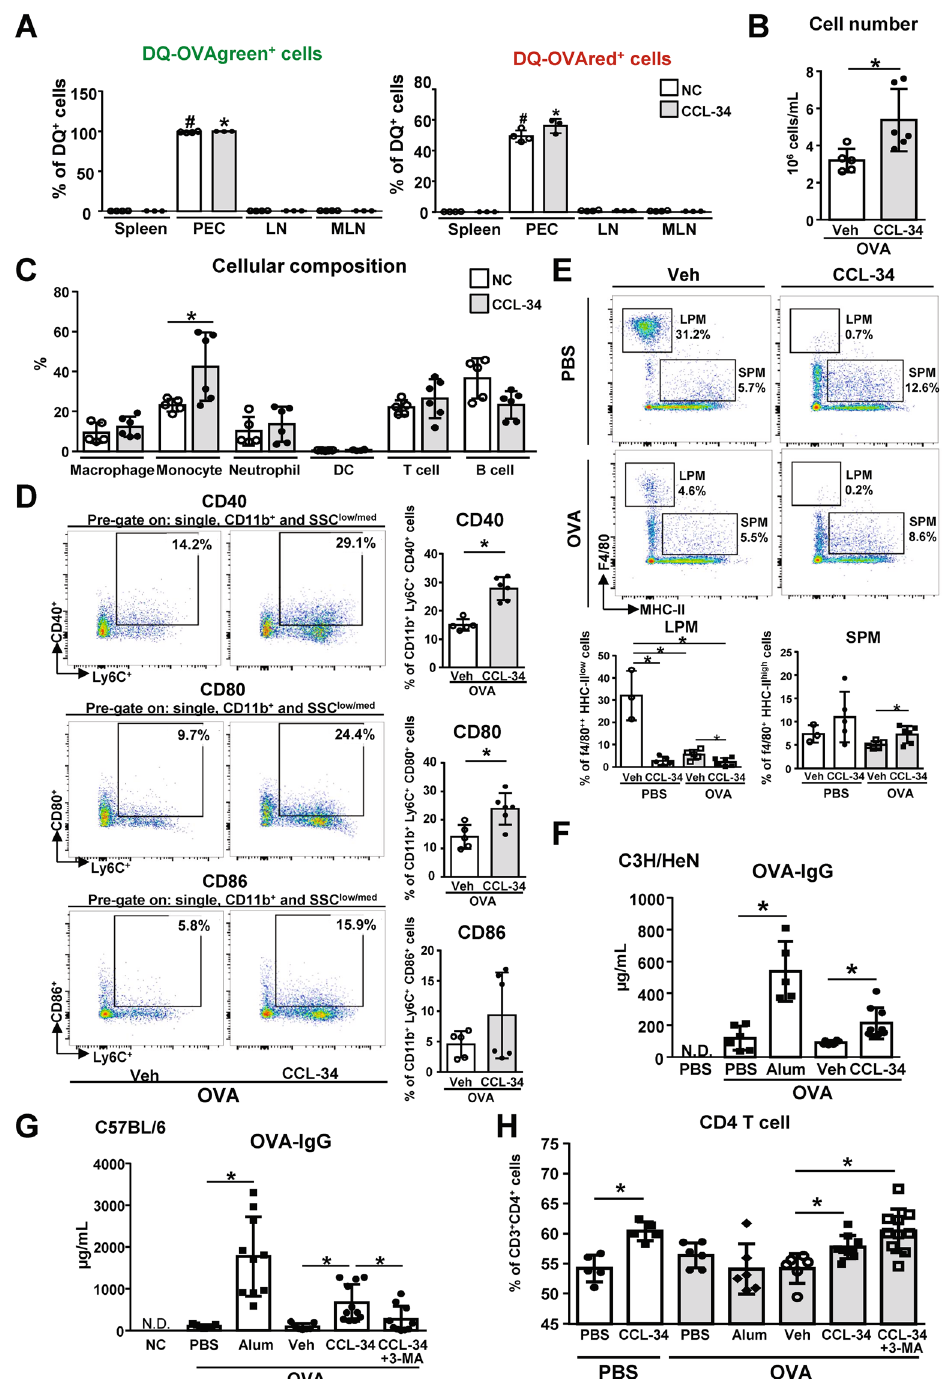
Figure 5. CCL-34 functions as an immune adjuvant in vivo . (A) The cells with Ag-processing ability were significantly increased in PEC of CCL-34-treated mice. C57BL/6 mice were injected intraperitoneally with DQ- OVA (1 mg/kg) in the presence or absence of CCL-34 (4 mg/kg). Cells were isolated from the spleen, peritoneal cavity, lymph nodes and MLN 24 hours later and analyzed by flow cytometry. The percentages of DQ-OVA green (digested OVA) and DQ-OVA red (digested and accumulated OVA) are shown. # p < 0.05 and * p < 0.05 indicate significant differences of PEC versus MLN, spleen or lymph nodes in vehicle group (n = 4) or CCL-34 group (n = 3). (B – E) C57BL/6 mice were injected intraperitoneally with OVA (100 μ g/mouse) in the presence or absence of CCL-34 for 24 hours. (B) Total cell number of PEC in CCL-34/OVA-immunized mice (n = 6) is higher than control group (n = 5). Total cell number of cells isolated from the peritoneal cavity was measured. (C) The percentage of monocytes (SSC low/med CD11b + Ly6C + ) in PEC is significantly increased in CCL-34/ OVA-injected mice. The PECs were stained and analyzed by flow cytometry. The percentages of macrophages (F4/80 + ), monocytes (SSC low/med CD11b + Ly6C + ), neutrophils (SSC high CD11b + Ly6C + ), DCs (CD11c +